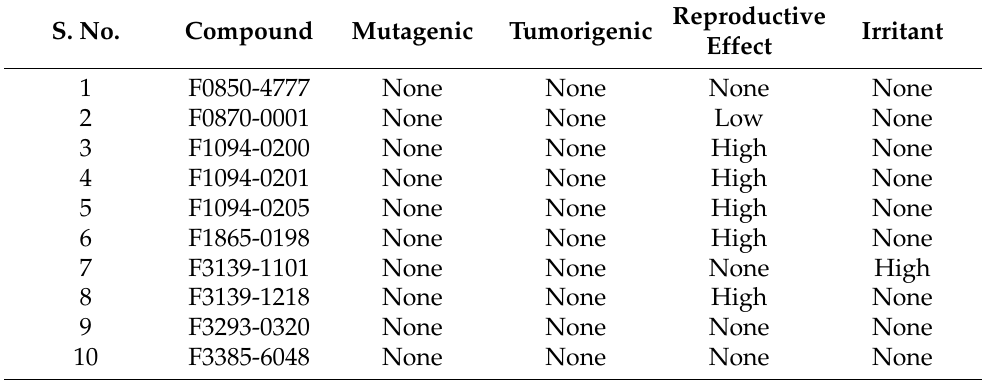
Table 3. Toxicity potential of 10 hits